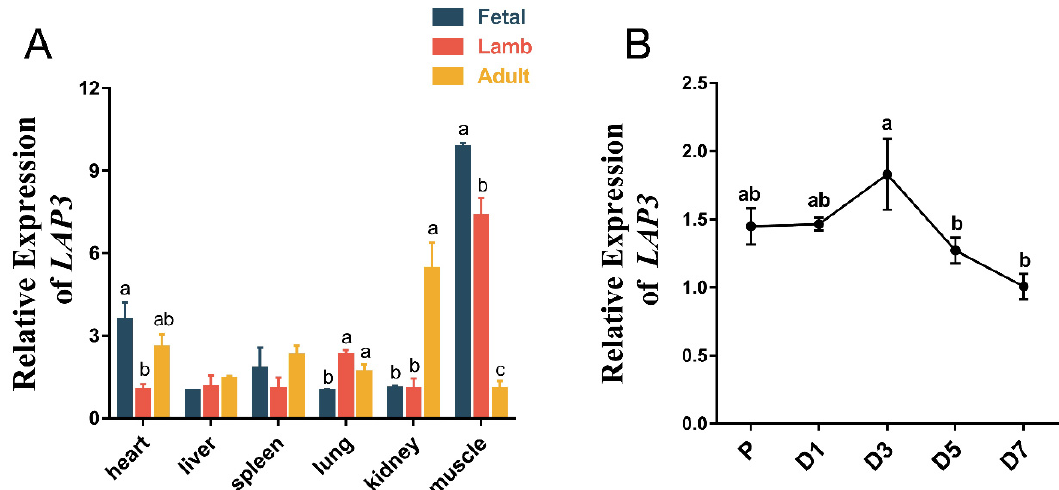
Figure 2. The expression levels of LAP3 mRNA in different tissues at different growth stages and embryonic myoblasts at different differentiation stages. ( A ) The expression levels of LAP3 mRNA were detected in the heart, liver, spleen, lung, kidney, and muscle tissues of fetal, lamb, and adult sheep by RT-PCR. ( B ) The expression levels of LAP3 mRNA were detected of embryonic myoblasts at proliferation (P) and the 1st, 3rd, 5th, and 7th day (D1, D3, D5, and D7) of differentiation by RT-PCR. Mean values with different letters indicated that LAP3 expression was significantly different at three development stages of fetal sheep, lambs, and adult sheep in the same tissue ( p < 0.05) according to Duncan’s multiple range test; data are shown as mean ± SEM, n = 3 biological replicates.